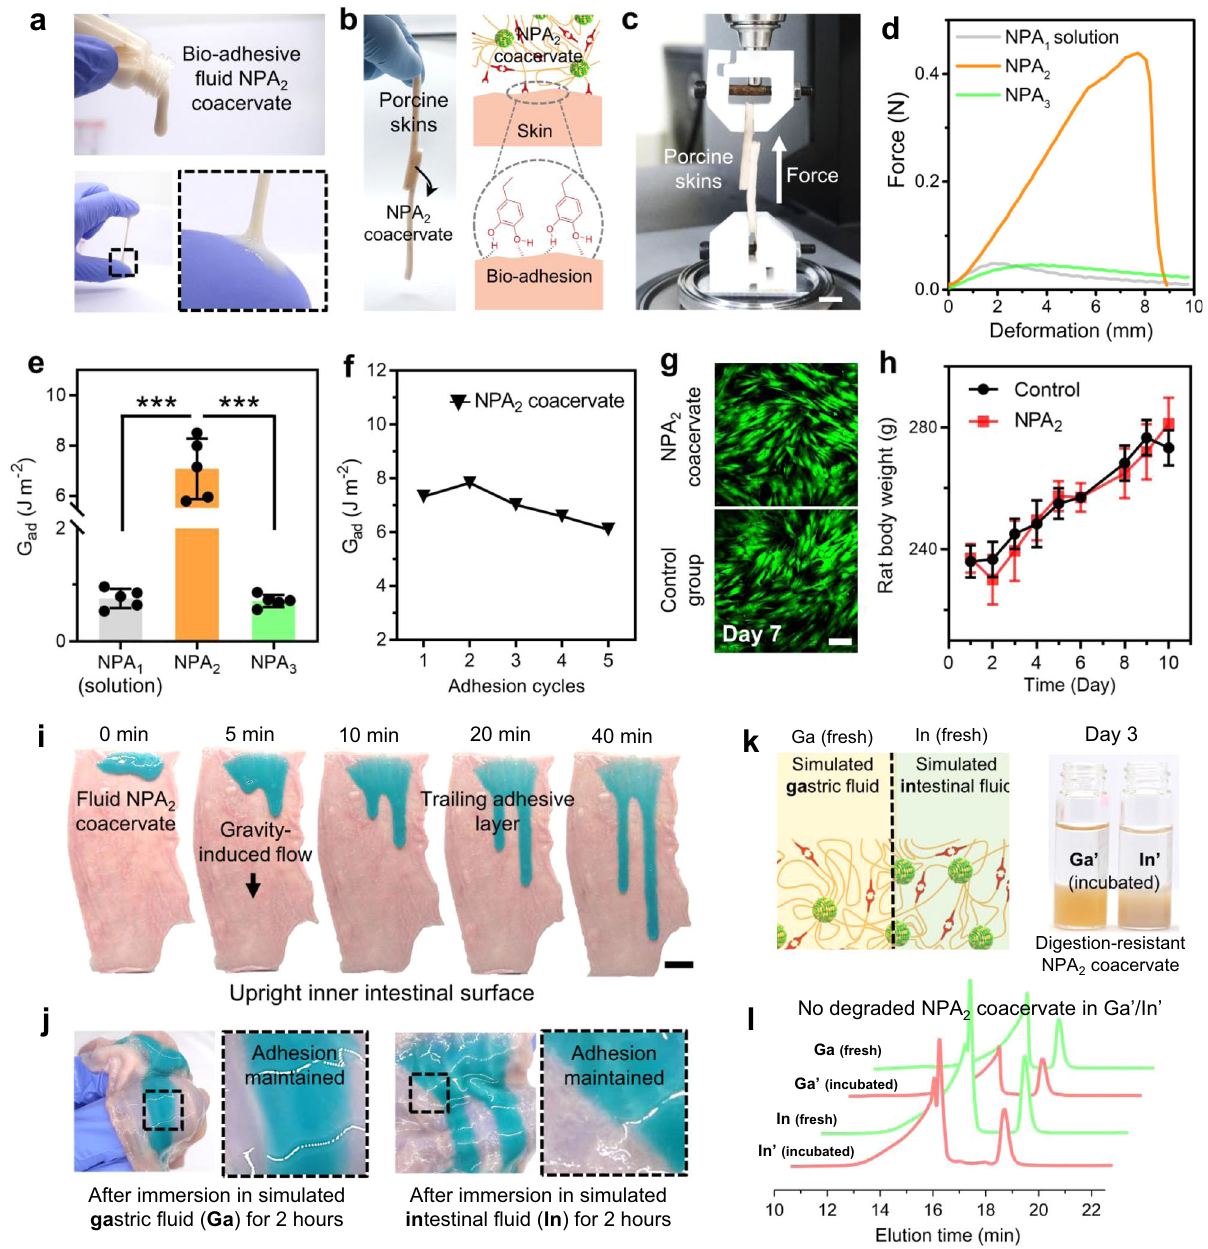
Fig. 2 Biocompatible and fl uid NPA 2 coacervate is wet bioadhesive and resistant to digestive enzymes. a Fluid NPA 2 coacervate formed a durable adhesive coating on the medical nitrile glove. b NPA 2 coacervate can glue two ribbons of porcine skin tissue together and hold the weight of the tissues. c Schematic of the lap-shear test to measure the adhesive energy (G ad ). Scale bar: 10 mm. d , e The adhesion performance of NPA 2 coacervate was much better than that of the controls. NPA 2 coacervate showed adhesive energy (G ad ) comparable with the previously reported values (around 2 – 10 J m − 2 ) for nanoparticle-based adhesives and polymeric adhesives. n = 5 independent lap-shear tests per group. f The hydrogen-bonding interactions derived from catechol groups ensure the stable and reversible adhesion energy level of NPA 2 coacervate during the successive bonding/debonding cycles. g The viability staining of human mesenchymal stem cells (hMSCs) also suggested excellent cytocompatibility of the NPA 2 coacervate. Scale bar: 200 μ m. h No signi fi cant differences in body weights were observed between the rats receiving oral administration of NPA 2 coacervate on days 1, 3, 5, 7, and 9, and untreated healthy rats during the 10-day toxicity evaluation. n = 3 biologically independent rats in control group, n = 4 biologically independent rats in NPA 2 group. i , j The fl uid NPA 2 coacervate coating (stained by Fast Green FCF) can adhere to the fresh and wet mucosa, fl ow down slowly, and remain stable after soaking in simulated gastric fl uid (Ga) and simulated intestinal fl uid (In) at 37 °C for 2 h, respectively. Scale bar: 15 mm. k , l GPC data of the fresh (Ga, In) and used simulated gastric or intestinal fl uid (Ga ′ , In ′ ) incubated with NPA 2 coacervate. No degraded or dissolved NPA 2 coacervate components were found in the simulated gastric or intestinal fl uid, respectively. Data were presented as mean ± SD. *** p < 0.001 (Ordinary one-way ANOVA). Source data are provided as a Source Data fi le for Fig. 2d – f,